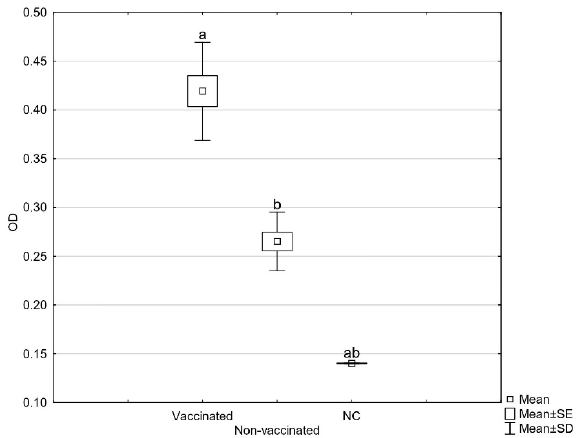
Figure 1. Average OD values of sera tested against E. coli strains used in the autogenous vaccine detected by in ‐ house ELISA before and three weeks after vaccination (NC = negative control). Statistically significant differences in OD values are marked with different letters (a, b).